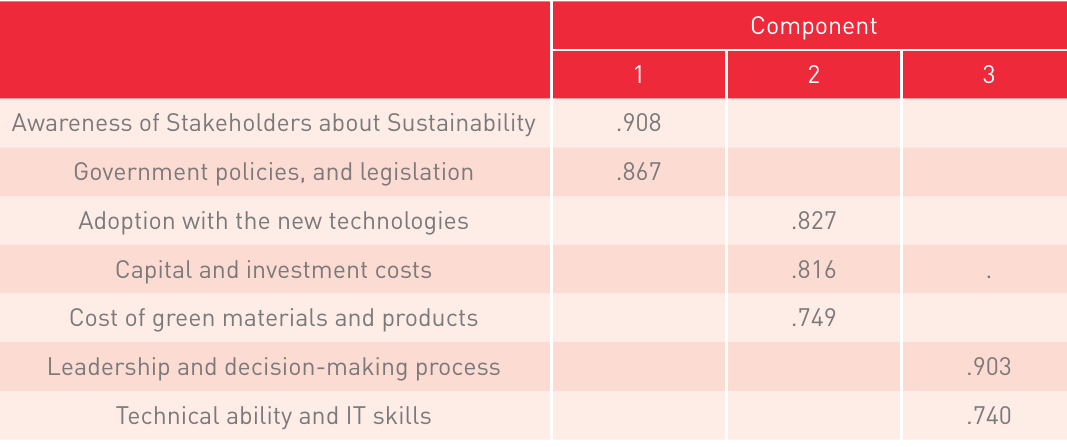
The Rotated matrix for the factor analysis